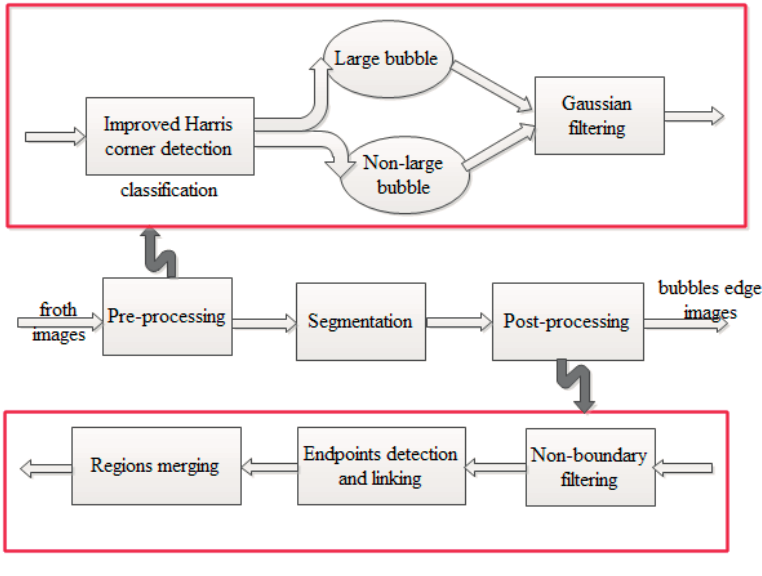
Figure 11. Working procedure of the proposed